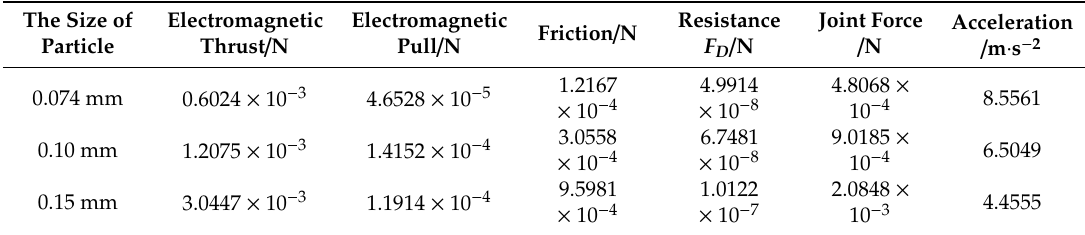
Table 5. Various forces acting on magnetic particles.